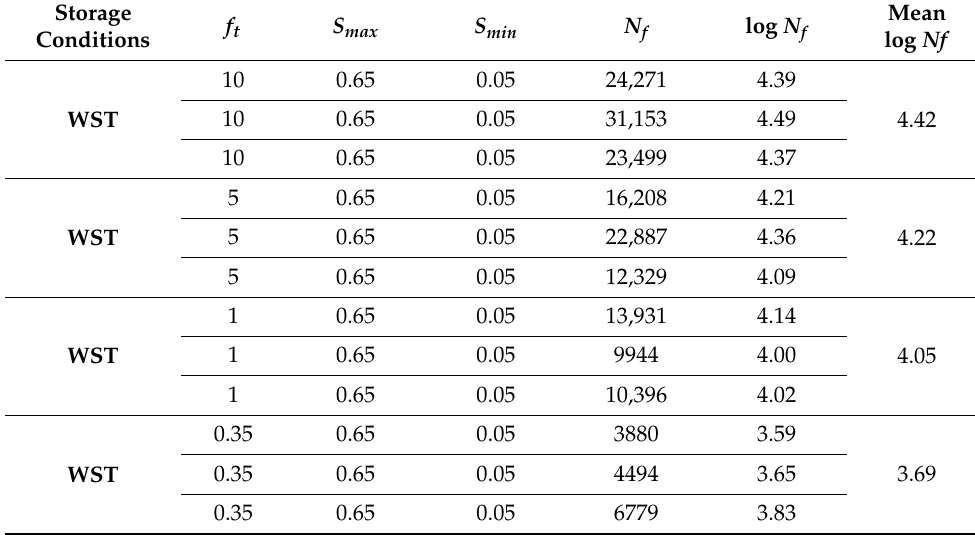
Table A3. The number of cycles to failure depending on the load frequency for HPC-1